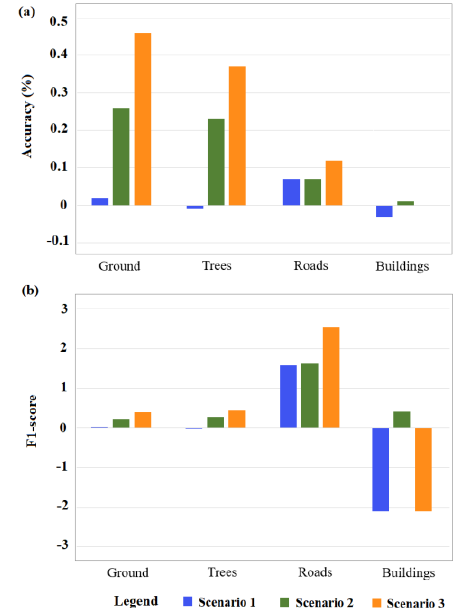
Figure 8. Comparison of classification metrics changes for each class (except vehicles) in all three scenarios: (a) accuracy and (b) F1-score changes between the two Pléiades acquisitions The transferability performance of a classifier across different acquisition times is an important question. How does the classifier trained on a dataset perform on a new dataset for the same area, but from a different acquisition time? For testing the cross-time performance, we applied the classifier trained on the Pleiades 1 st acquisition on the test set of Pleiades 2 nd acquisition and vice versa and compared the prediction performance to the one achieved when training and test set are from the same acquisition time. The results are shown in Table 4, for the F1- score in each scenario.